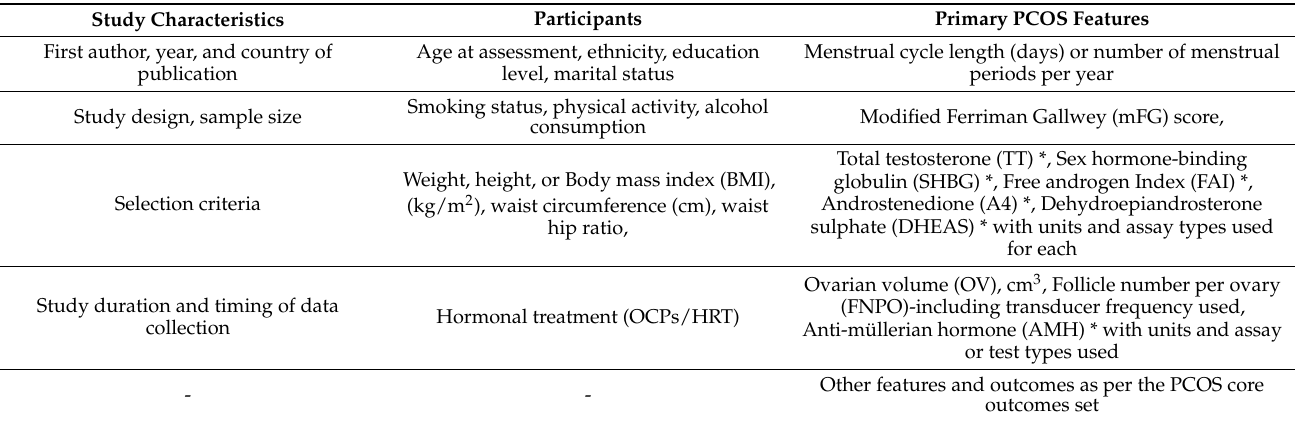
Table 2. IPD to be obtained from included